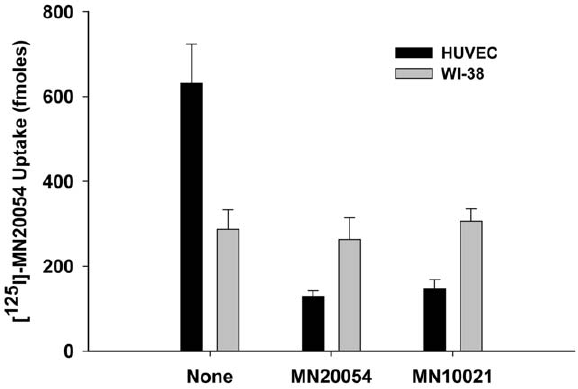
Figure 7. Binding of [ 125 I] – MN20054 to Fibroblasts. HUVEC and WI-38 fibroblasts (CCL-75 TM ; ATCC) were grown to confluence in 12-well tissue culture plates. To each of triplicate wells was added 20 pmol of [ 125 I]-MN20054 in the presence of either buffer alone, a 100-fold molar excess of MN20054, or a 100-fold molar excess of MN10021. The plates were incubated for 60 min at 37 u C with gentle rocking, the wells aspirated and quickly washed 3X with 2.0 ml each of ice-cold PBS/BSA and 1.0 ml of 1.0 N NaOH added to each well to solubilize the cells. Nine-tenths ml of solubilized cells was then removed from each well and cell-associated radioactivity determined by gamma scintillation spectrophotometry.